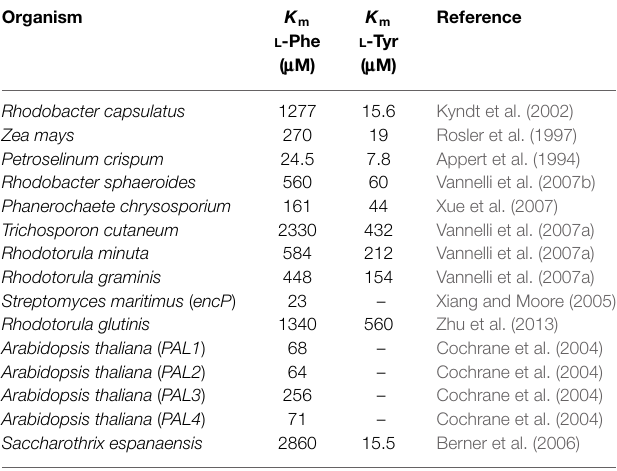
TABLE1 | Kineticparametersforphenylalanineammonialyaseandtyrosine ammonia lyase enzymes from various organisms .